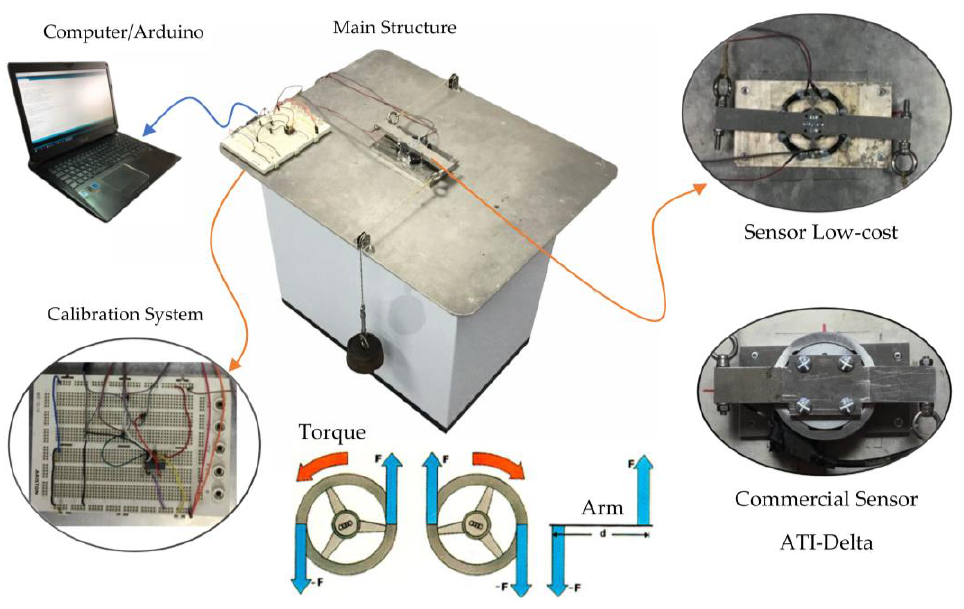
Figure 14. Calibration bench.